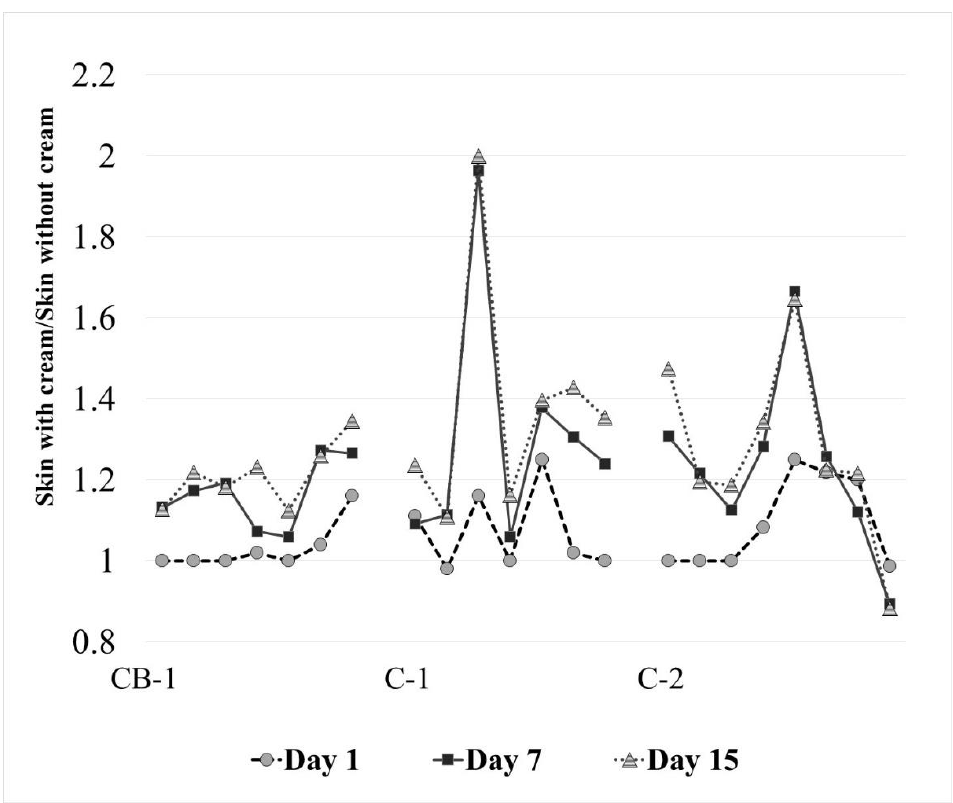
Figure 4. E ff ects of the creams in skin hydration (UA) of patients with psoriasis: ratio between values obtained with creams prepared with three types of water (cream with laboratory water (CB-1), cream with thermal water (C-1), cream with concentrated thermal water 2:1 and (C-2)) and with no cream application.